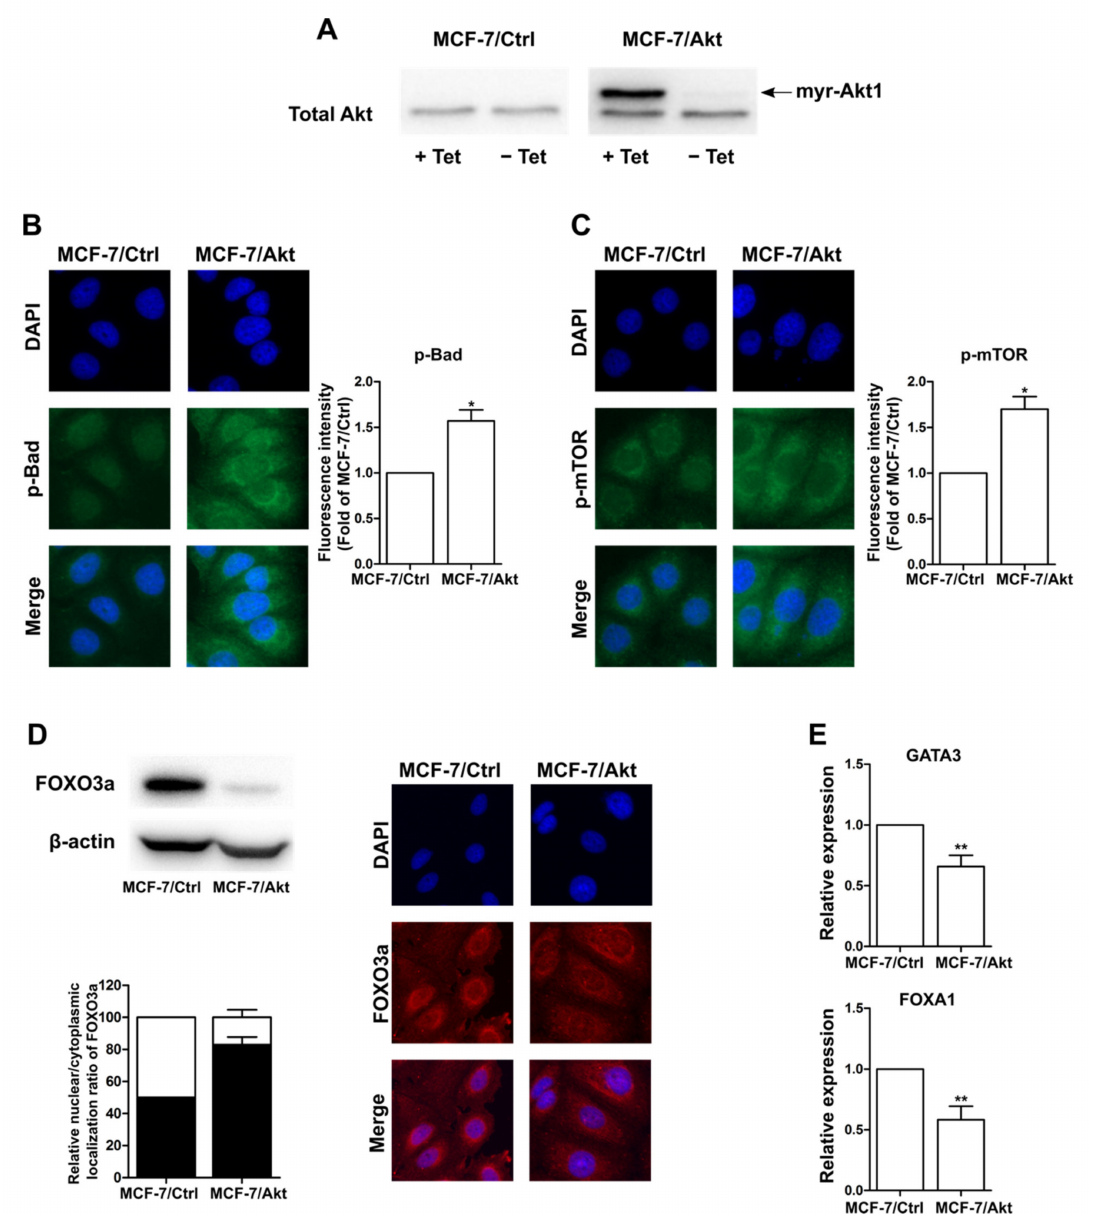
Figure 1. Characterization of MCF-7 cell clones expressing wild-type Akt (MCF-7/Ctrl) and its constitutively active form (MCF-7/Akt). ( A ) Equal amounts of protein extracts from MCF-7/Ctrl cells and MCF-7/Akt cells treated with or without tetracycline (Tet) were analyzed by Western blotting with an antibody specific for Akt. Notably, myr-Akt1 has a larger molecular mass than wild-type Akt1. ( B , C ) Protein expression and subcellular localization of phospho-Bad ( B ) and phospho-mTOR ( C ) in MCF-7/Ctrl cells and MCF-7/Akt cells, as examined by immunofluorescence. ( D ) Equal amounts of protein extracts from MCF-7/Ctrl cells and MCF-7/Akt cells were analyzed by Western blotting with an antibody specific for FOXO3a (left, above). Protein expression and subcellular localization of FOXO3a in MCF-7/Ctrl cells and MCF-7/Akt cells examined by immunofluorescence (right). Quantification of the nuclear/cytoplasmic localization ratio of FOXO3a (left, below). Fluorescence intensity in the nucleus and cytoplasm of each cell was measured using ImageJ software. The median nuclear/cytoplasmic localization ratio of the control condition was used as a threshold to determine the percentage of cells below (black) and above (white) this threshold in each condition. ( E ) Gene expression of GATA3 (above) FOXA1 and (below) in MCF-7/Ctrl cells and MCF-7/Akt cells, as revealed by RT-PCR. Statistical analyses were performed with a Mann-Whitney test. * p -value < 0.05, ** p -value < 0.01 is considered to be significantly different from the MCF-7/Ctrl cell